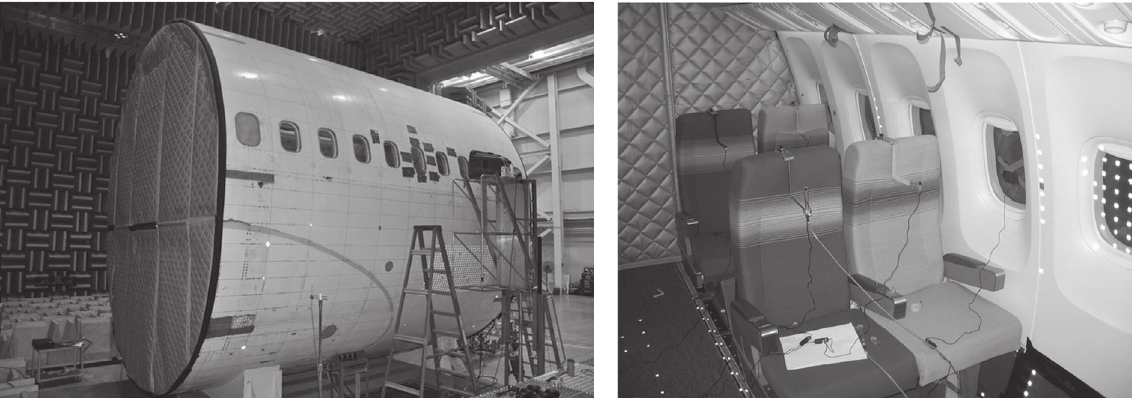
Fig. 8. 767-200 fuselage resting in cradles in INTF anechoic chamber. Fig. 9. Interior of 767 barrel section with passenger seats. Acoustic wall is visible in background.